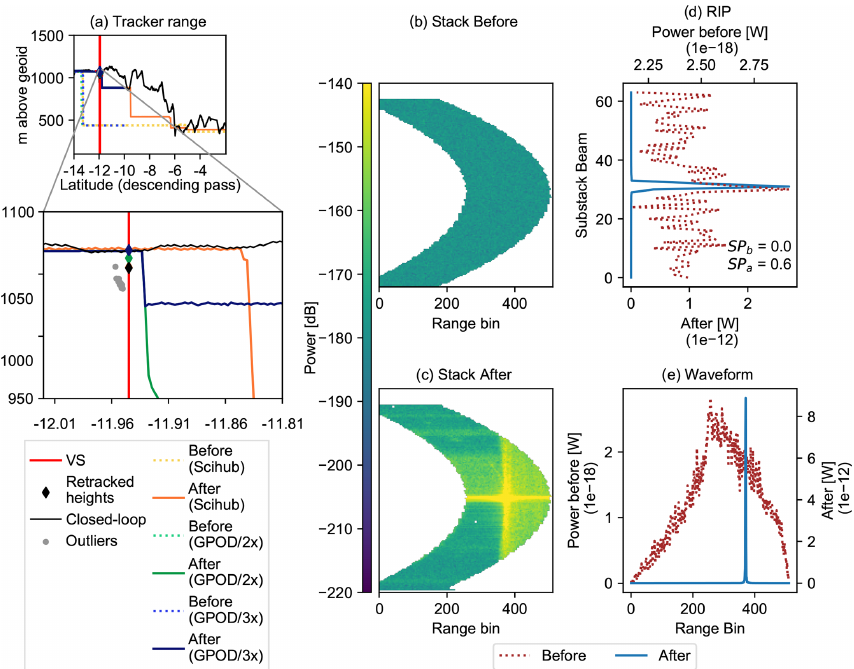
Figure 9. Level-1b data at virtual stations (VSs) on ground track 135 (descending path). (a) Tracker range before, during and after the OLTC update and outliers using GPOD dataset with double window extension. (b–e) Waveform statistics. The waveforms have been processed on GPOD: (b) and (c) stack waveforms, (d) range integrated power (RIP) and (e) waveforms before and after the Sentinel-3A OLTC update.